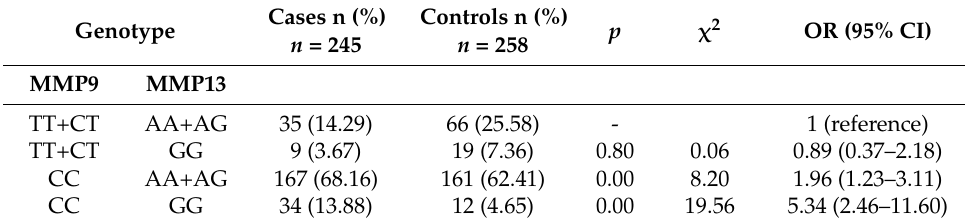
Table 8. Risk of lung cancer in association with MMP9 and MMP13